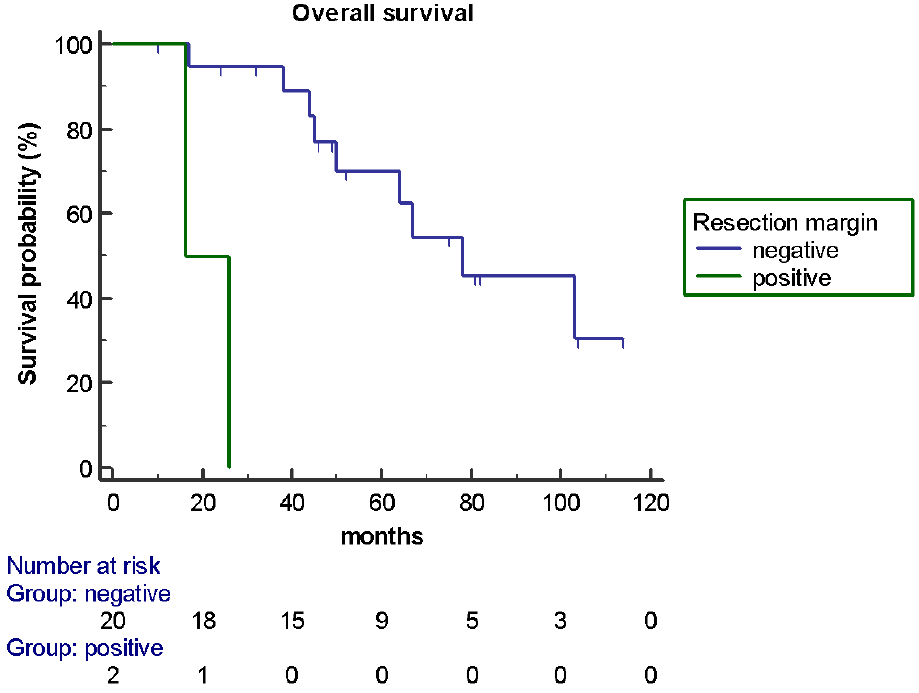
Figure 3. OS according to resection margin of liver metastases (R0 versus R1: 78 versus 16 months; HR 0.083, p < 0.0001).